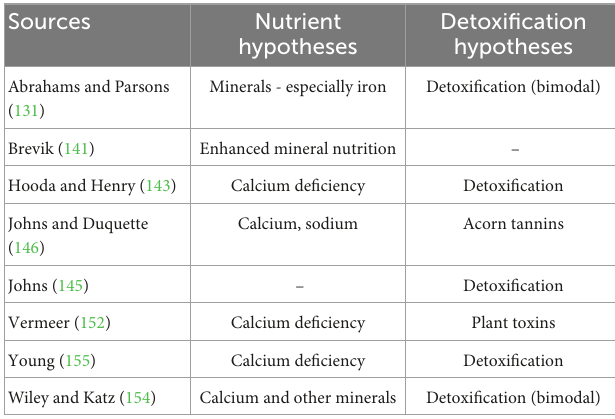
iron, calcium, and potassium or vitamins such as cobalamin, that may otherwise be absent from the diet, but whose transfer to the developing foetus is quintessential for its optimal